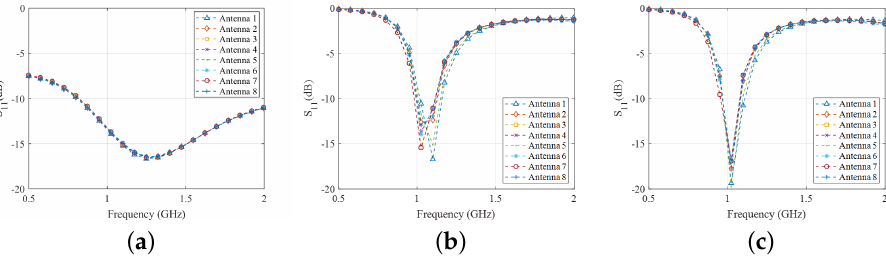
Figure 12. Calculated reflection coefficients in the “no target” scenario for ( a ) the spear patch antennas, ( b ) the PSMAs and ( c ) the MTS-enhanced